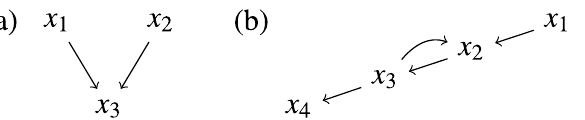
Figure 4. Current categorization of edges takes a node-centric view, however, a new edge categorization from an edge-centric perspective clarifies the roles that edges play in controlling a